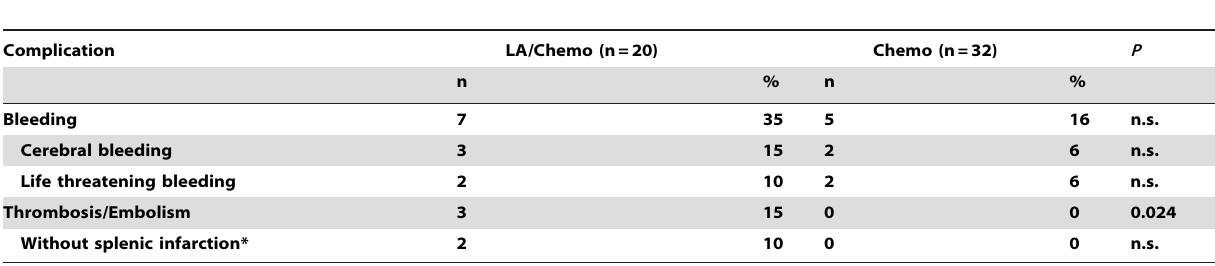
Table 5. Complications within 7 days of